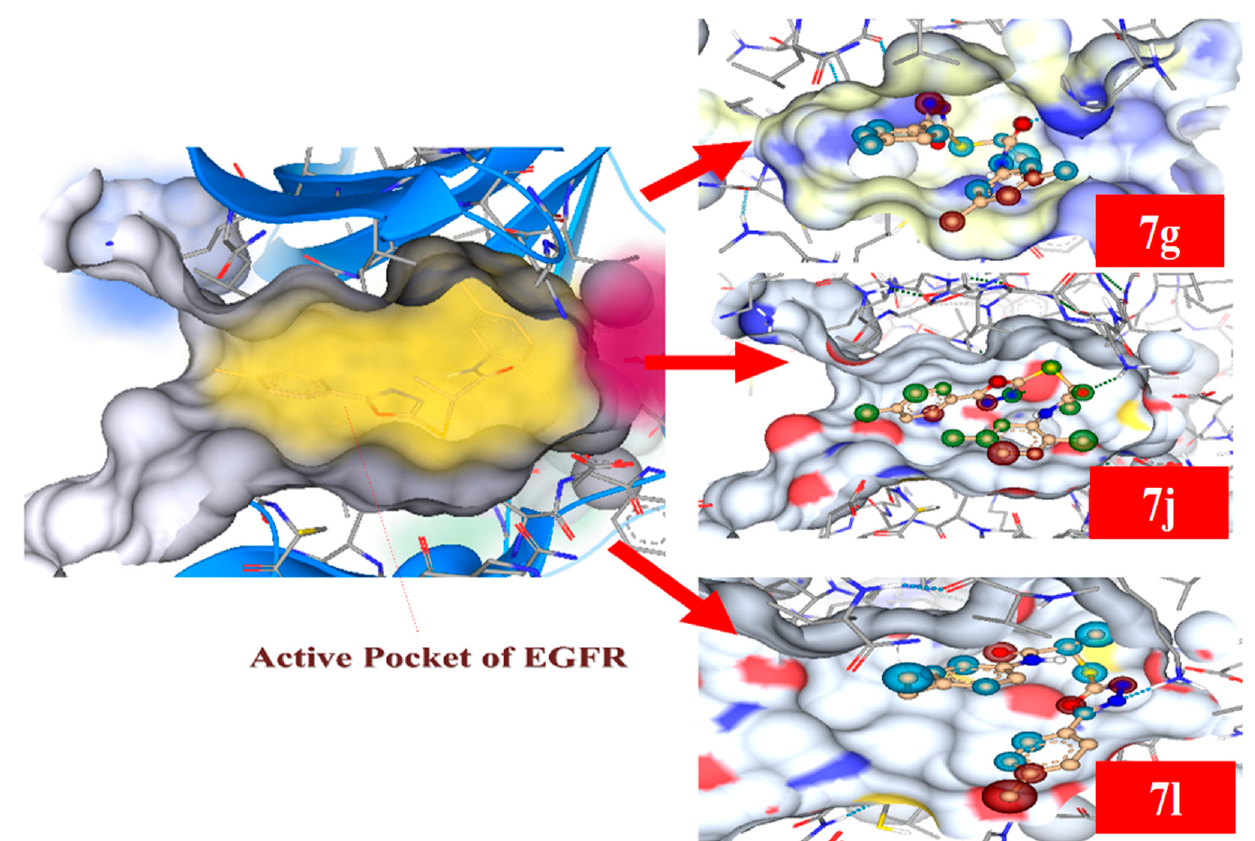
Figure 7. 3D diagram showing the binding interactions of 7g , 7j and 7l within the active pocket of Protein EGFR.